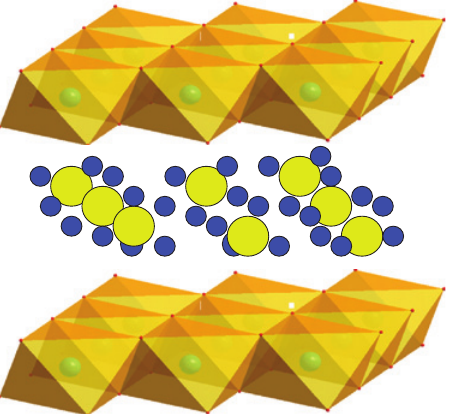
Figure 6: Structural model proposed for the halide-hydroxy series of nickel(II). The yellow and blue spheres hold for halogen and water molecules, respectively. Adapted with permission from